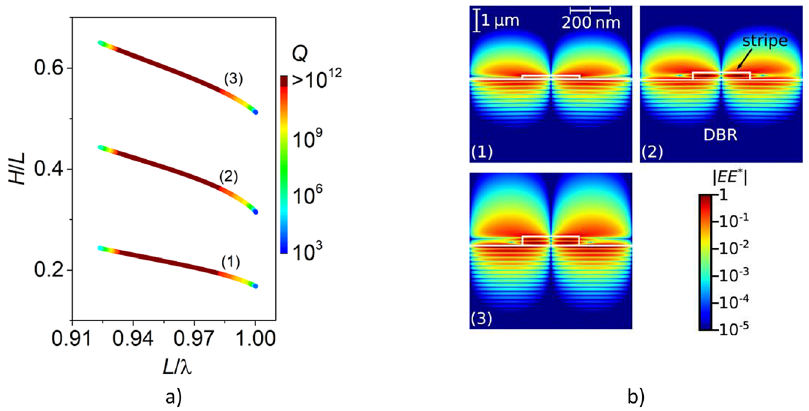
light since zeroth order emission is prohibited by the mode Figure 3a illustrates the dispersion curves of the anti- symmetric modes in the con fi guration composed of the grating and the DBR. The dark red regions in the dispersion curves of the modes indicated by (1) – (3) in Figure 3a represent values above 10 12 . These values exceed the available computational precision and are therefore considered to be in fi nite, indicating BICs [5, 30] that do not disappear when the parameters of the grating vary in a limited range. The Q -factors of the modes remain in fi nite within an L / λ interval of 0.05 width and decay abruptly outside the dark red region, signi fi cantly below 1000, becoming untraceable by the numerical model. Therefore, these BICs can be considered as extended in the space of the wavelength and the grating parameters have similar properties to an SP BIC. The distributions of the modes indicated in Figure 3a are depicted in Figure 3b.